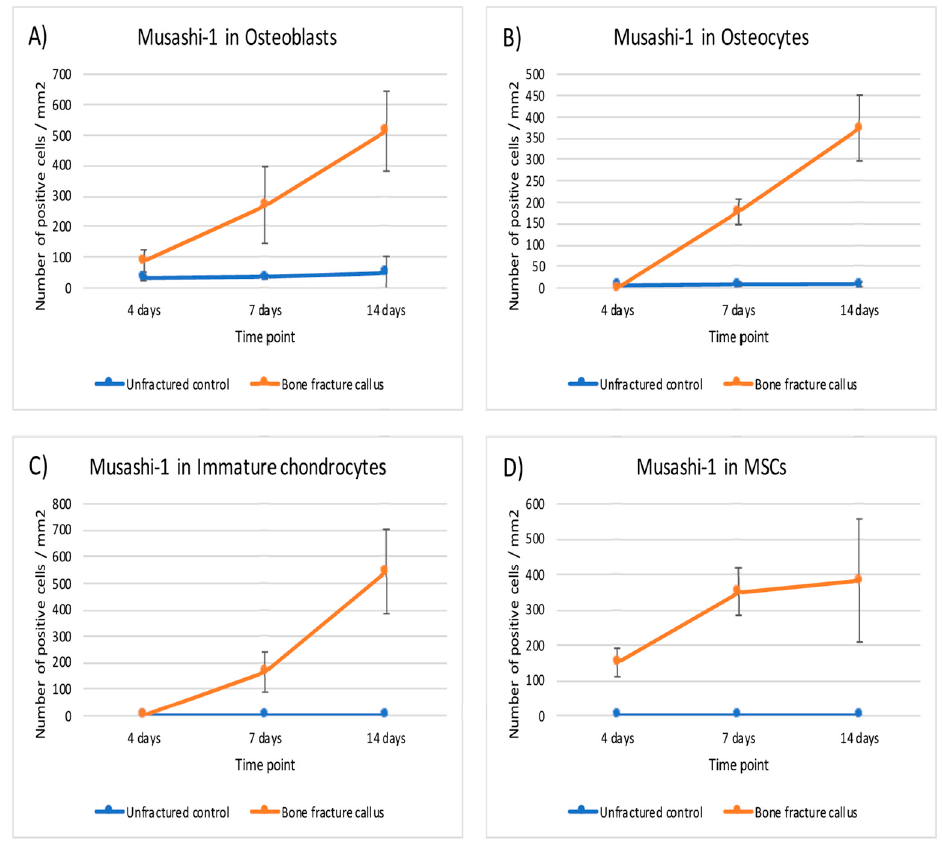
Figure 5. Graphical representation of the expression of musashi-1 in bone fracture callus (orange line) and unfractured control areas (blue line) over time in ( A ) osteoblasts, ( B ) osteocytes, ( C ) immature chondrocytes and ( D ) MSCs (mesenchymal stromal cells).